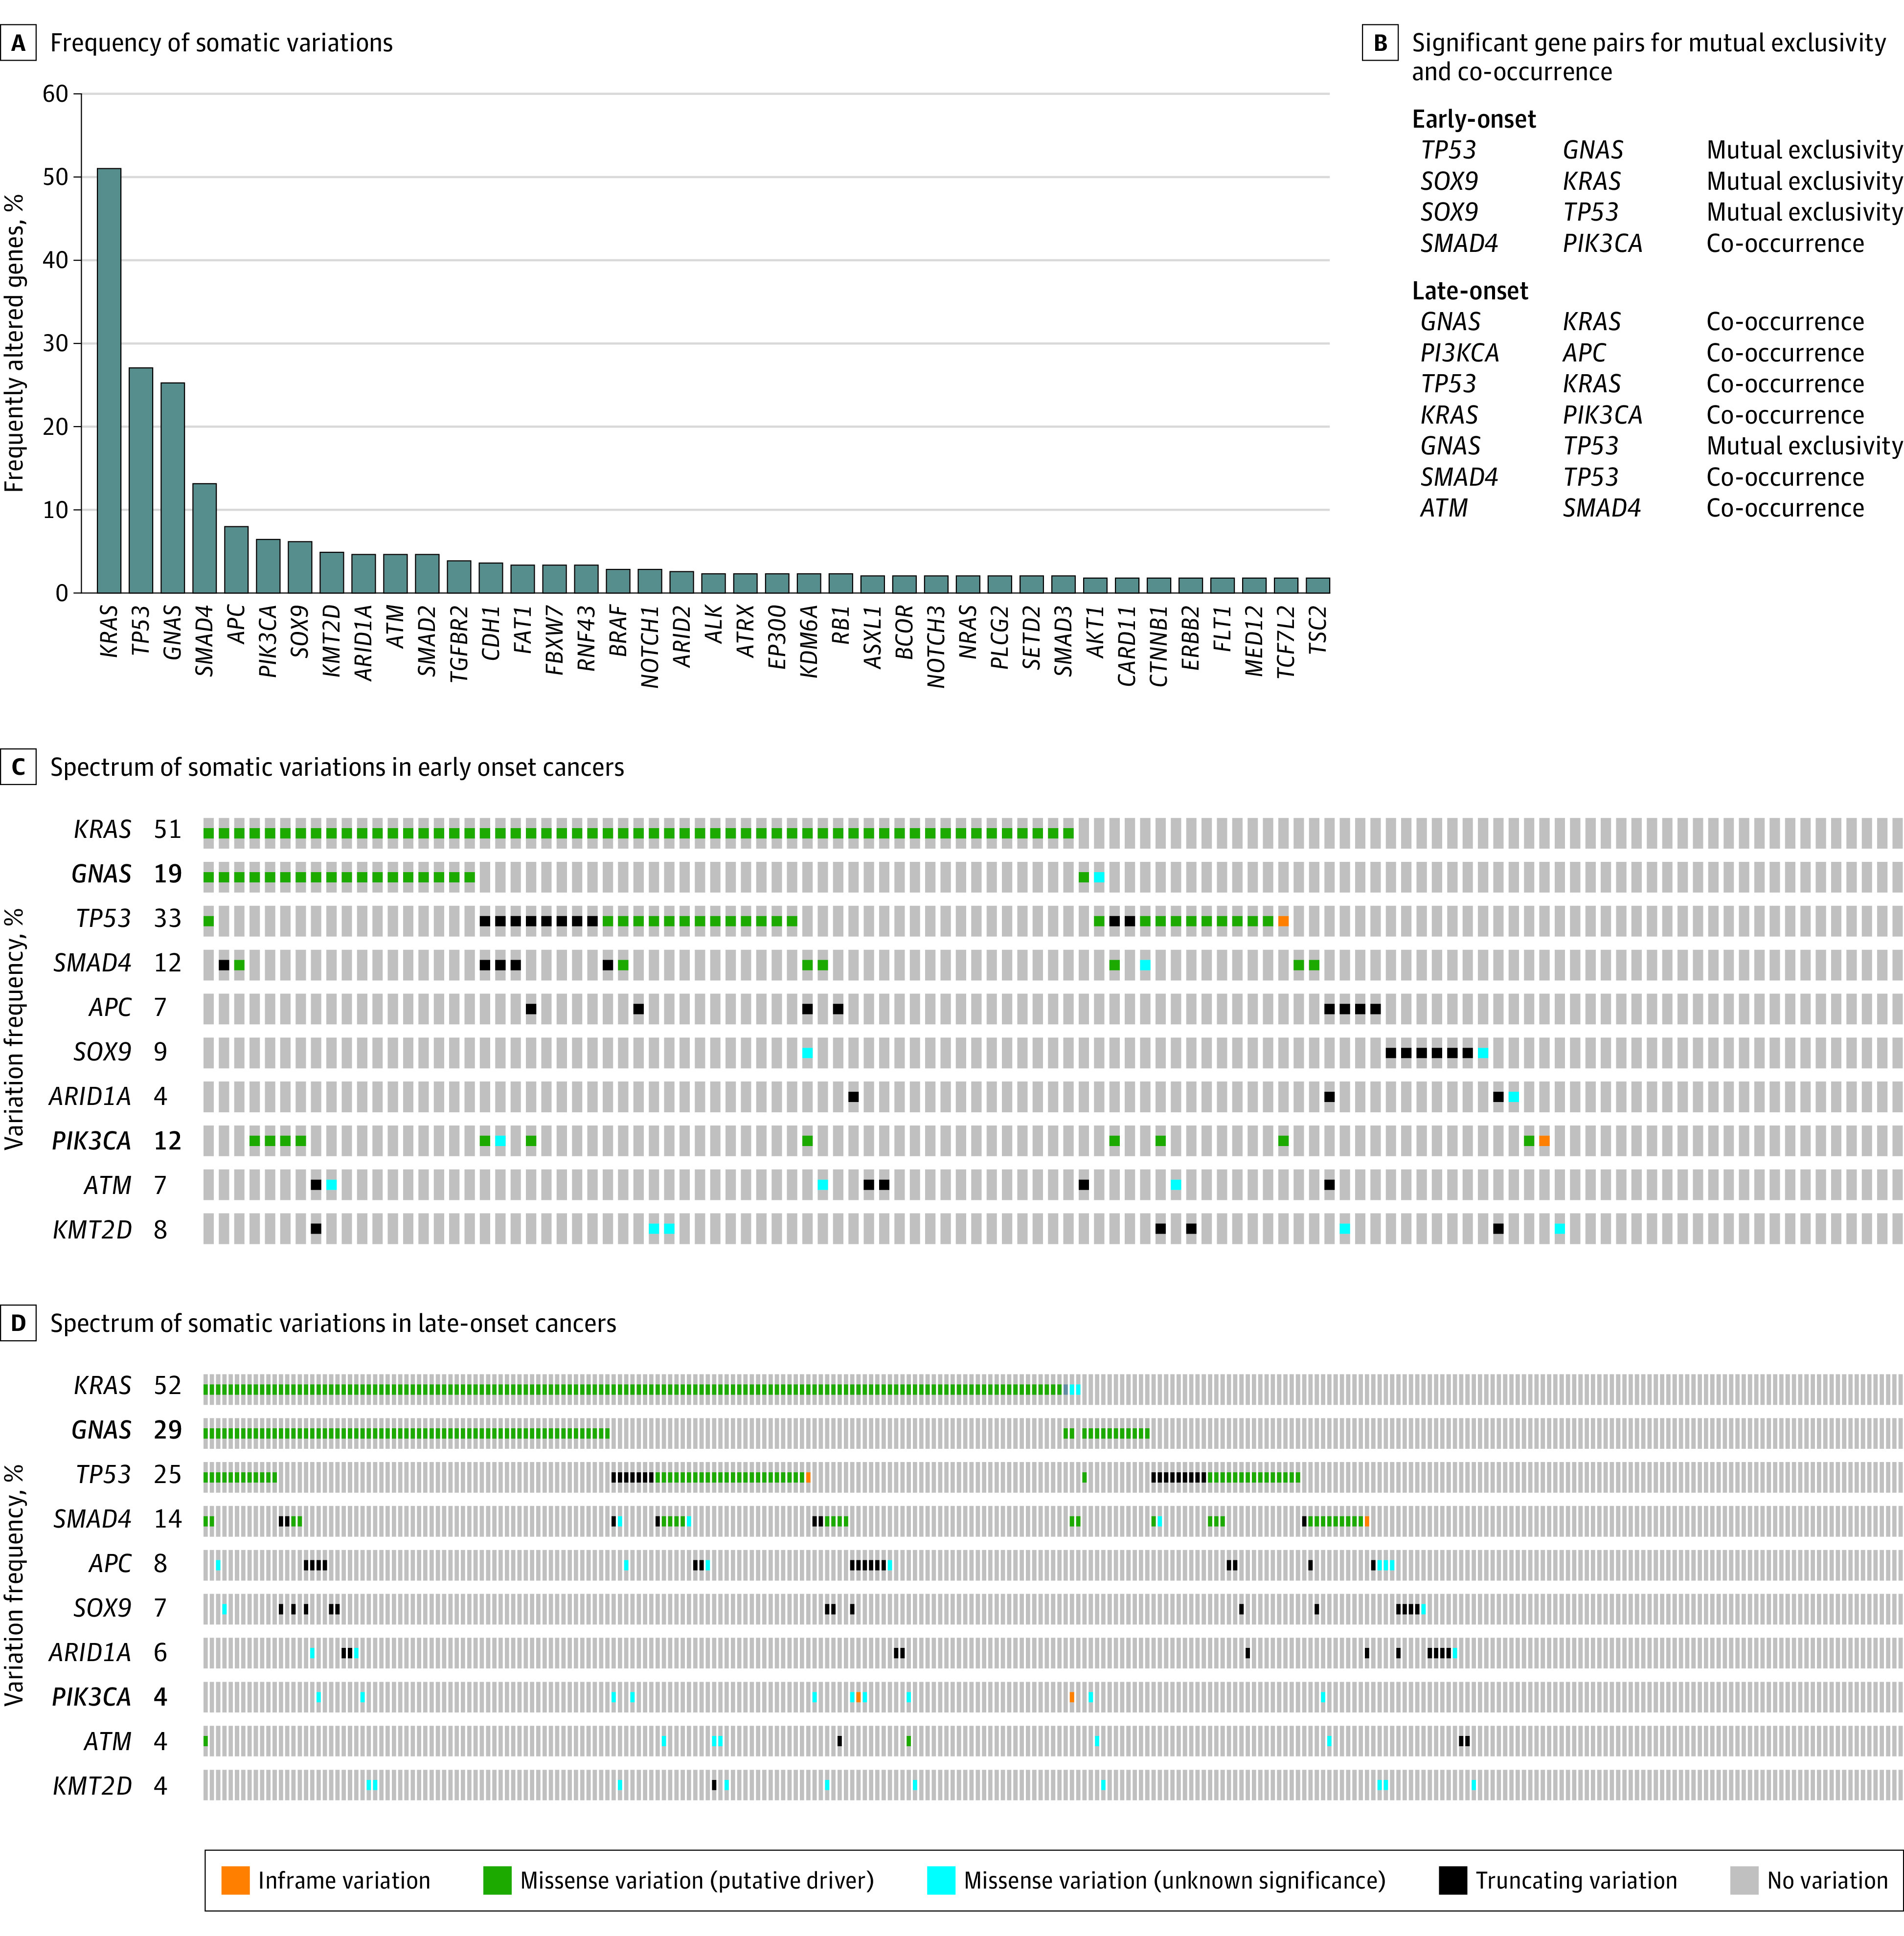
Genomic Landscape of Appendiceal Cancers by Age at Disease Onset